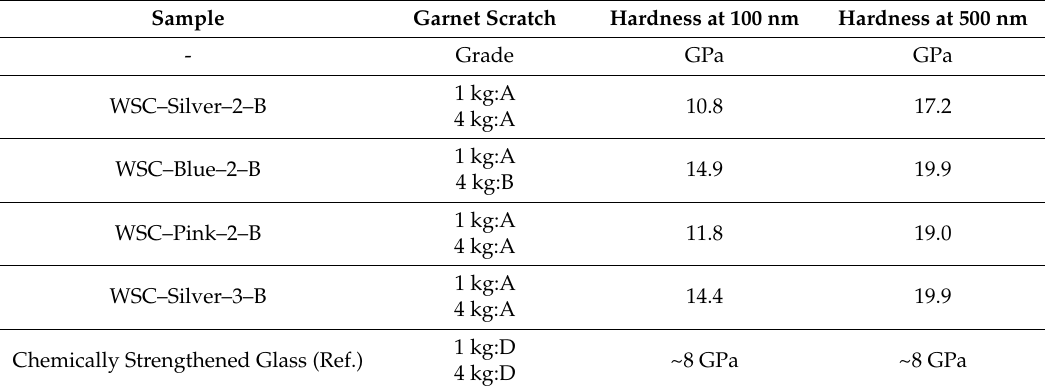
Table 2. Summary of key coating mechanical properties for Design Strategy 2